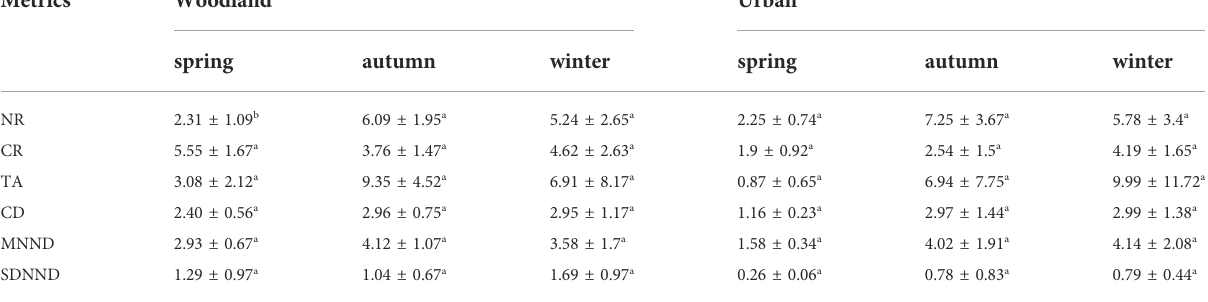
TABLE 3 The community-level metrics at woodland and urban sites in spring, autumn, and